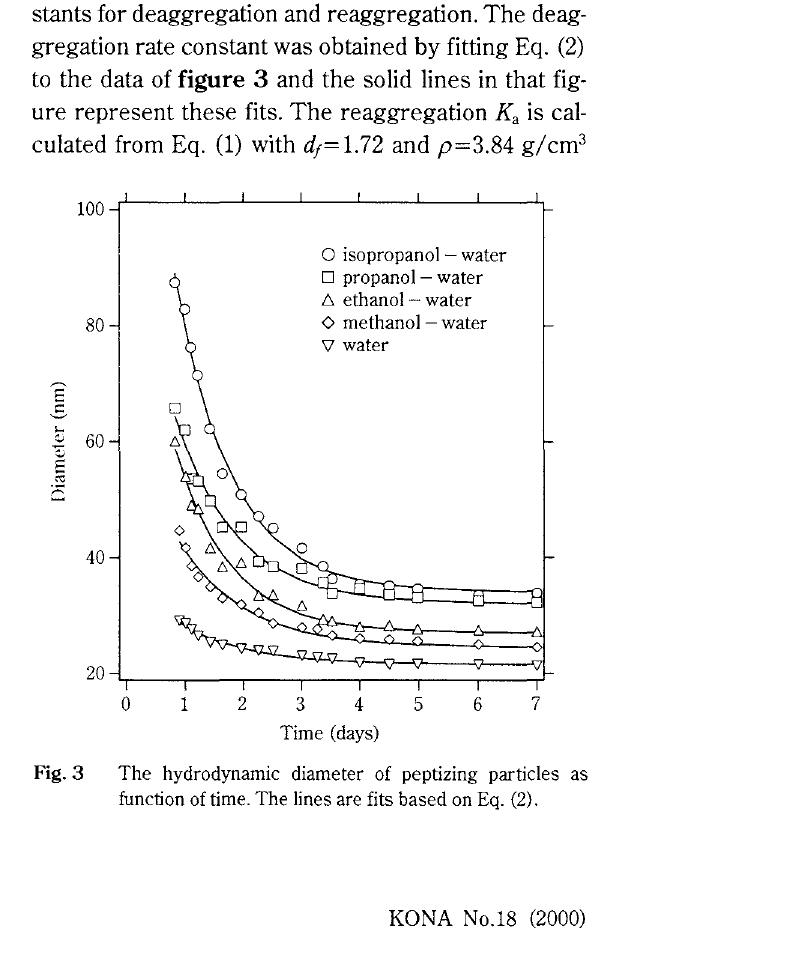
The hydrodynamic diameter of peptizing particles as function of time. The lines are fits based on Eq.